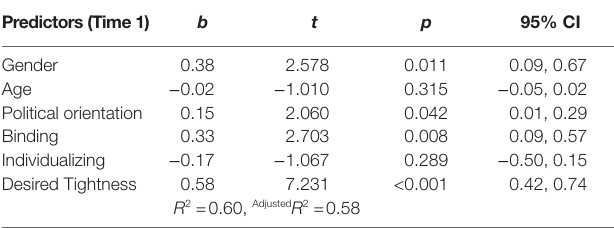
TABLE 4 | Predictive effects of the moral foundations and covariates on subsequent desired tightness, Study